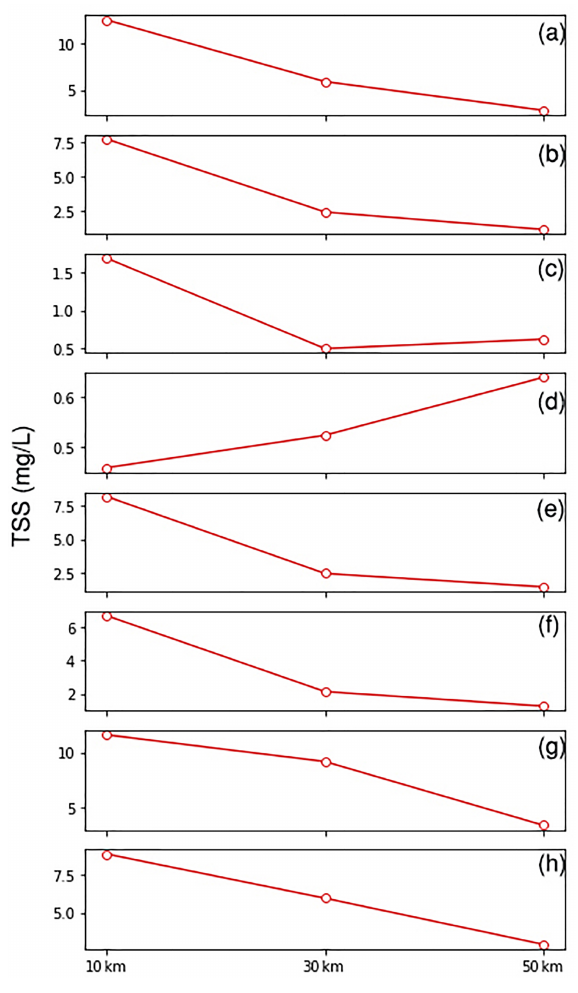
Figure 12. Average TSS estimates (mgL − 1 ) computed from 2003 to 2019 for each of the eight rivers (area_01, a ; area_02, b ; area_03, c ; area_04, d ; area_05, e ; area_06, f ; area_07, g ; and area_08, h ) and their relevant transect points with a distance of 10km (coastal waters), 30km (territorial waters), and 50km (open- ocean waters) from the shoreline. Note the varying TSS scales on the ordinate axes in each